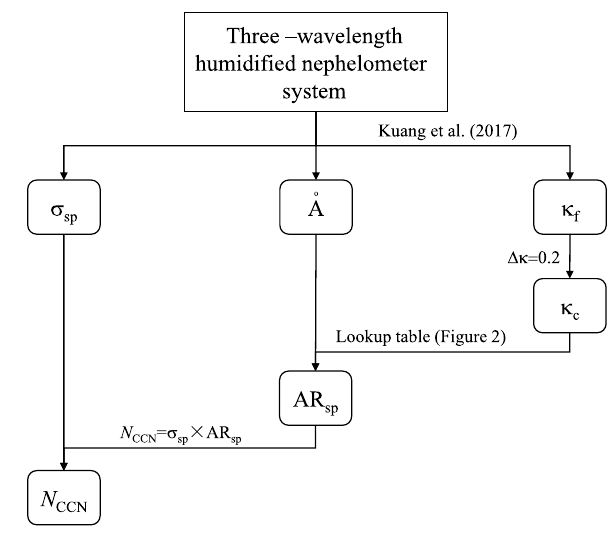
σ sp CCN prediction based on measurements of a humidified nephelometer